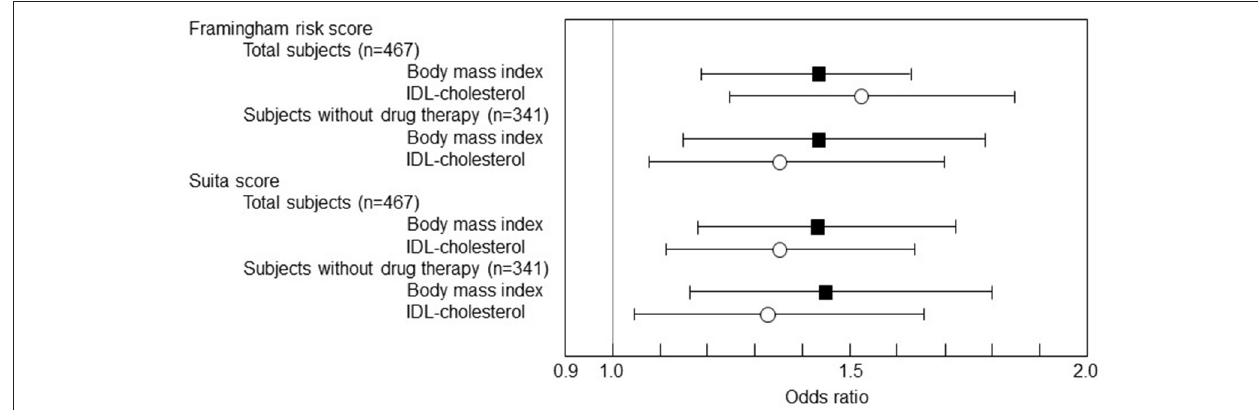
FIGURE 1 | A univariate logistic regression analysis of body mass index (BMI) and cholesterol levels of intermediate-density lipoprotein (IDL) to Framingham risk score (F-score) and Suita score (S-score). The logistic regression results were shown as odds ratios ( OR s) and 95% CIs . The 1 SD increase in BMI was significantly associated with F-score 10-year CHD risk > 10% ( OR 1.430, 95% CI 1.187–1.722, p = 0.002 in total subjects and OR 1.431, 95% CI 1.146–1.787, p < 0.0001 in the subjects without drug therapy). The 1 SD increase in BMI was also associated with S-score 10-year CHD risk > 10% ( OR 1.420, 95% CI 1.175–1.717, p = 0.0003